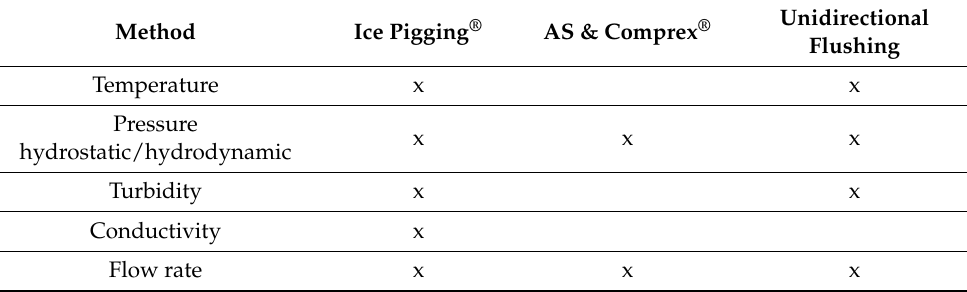
Table 1. Parameters of water monitored on-site by on-line sensors.